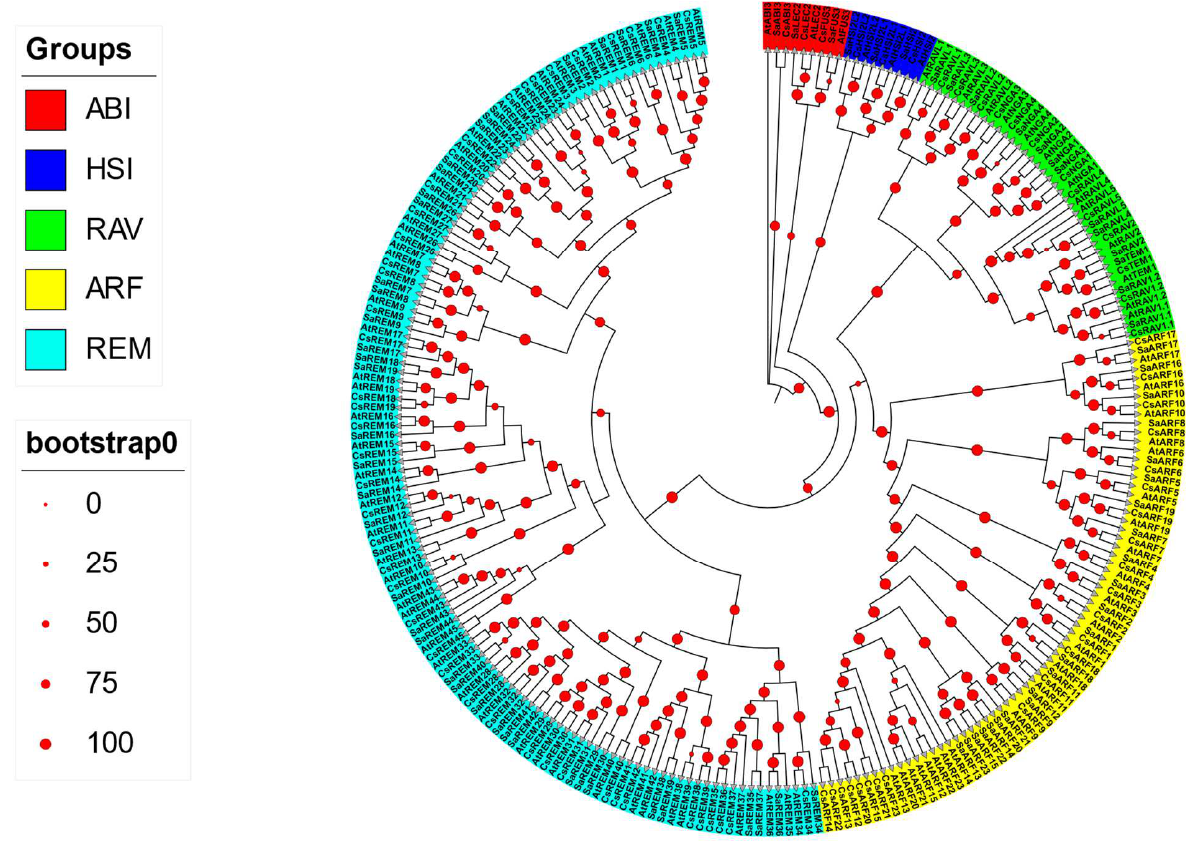
Figure 1. Maximum likelihood tree of C. sativa B3 DNA-binding superfamily with two other species, A. thaliana and S. alba .